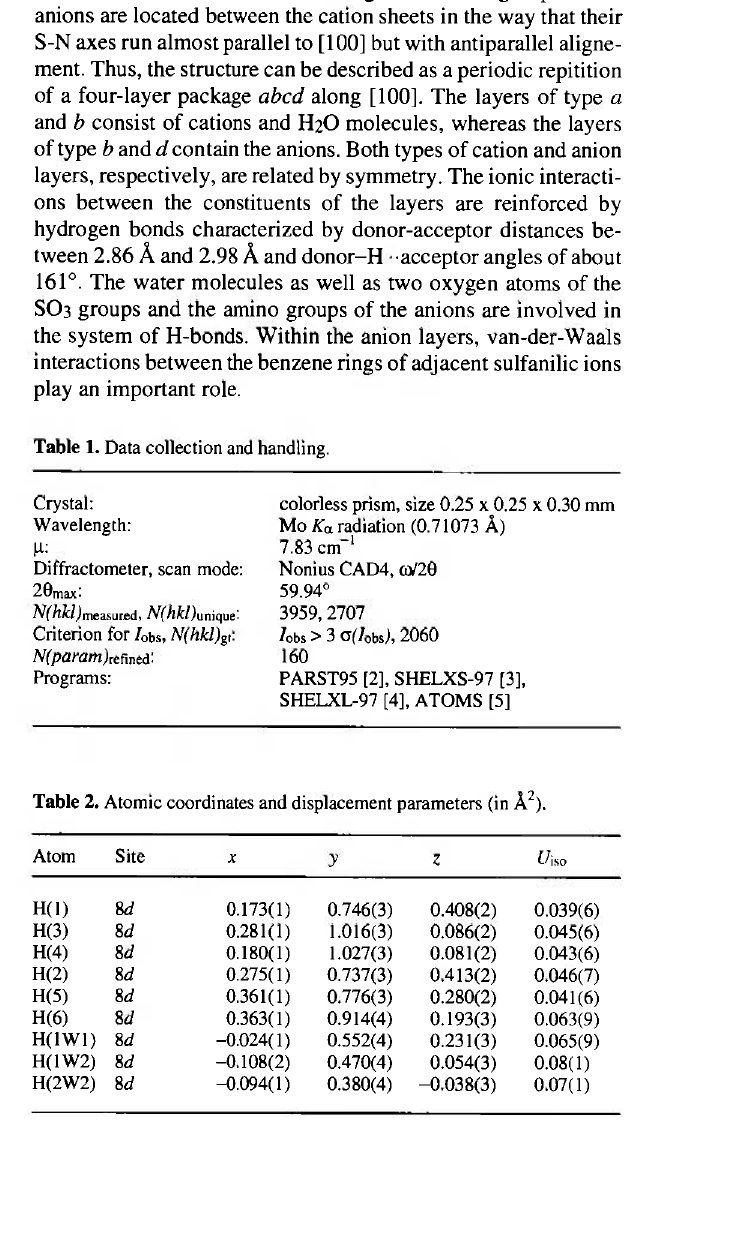
Table 1. Data collection and handling.